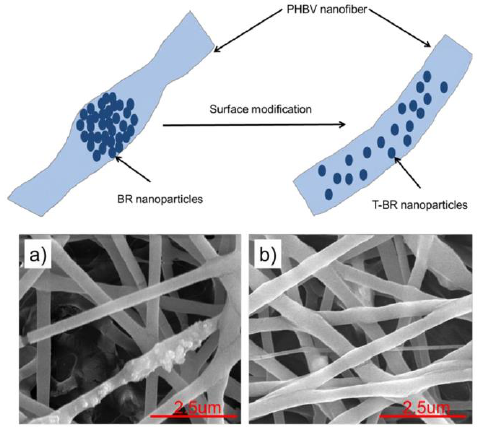
Figure 7. Schematic illustration and SEM images of PHBV nanofibers containing 15% of ( a ) bredigite (BR) and ( b ) T-BR nanoparticles